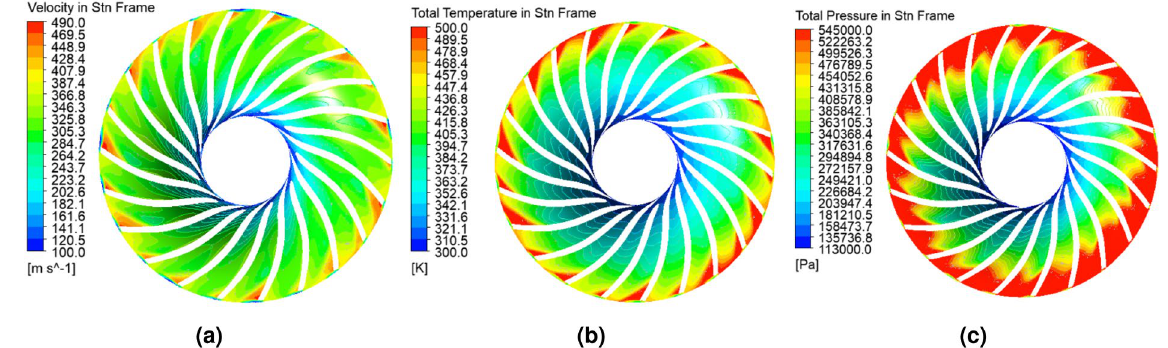
Figure 3. Distribution of ( a ) total velocity, ( b ) total temperature and ( c ) total pressure on the surface halfway through the flow channel (Ansys CFX 35